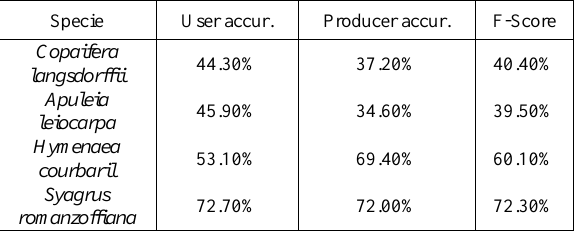
Table 3. Result of the 10-fold cross validation model of the RF in the pixel-based approach classification